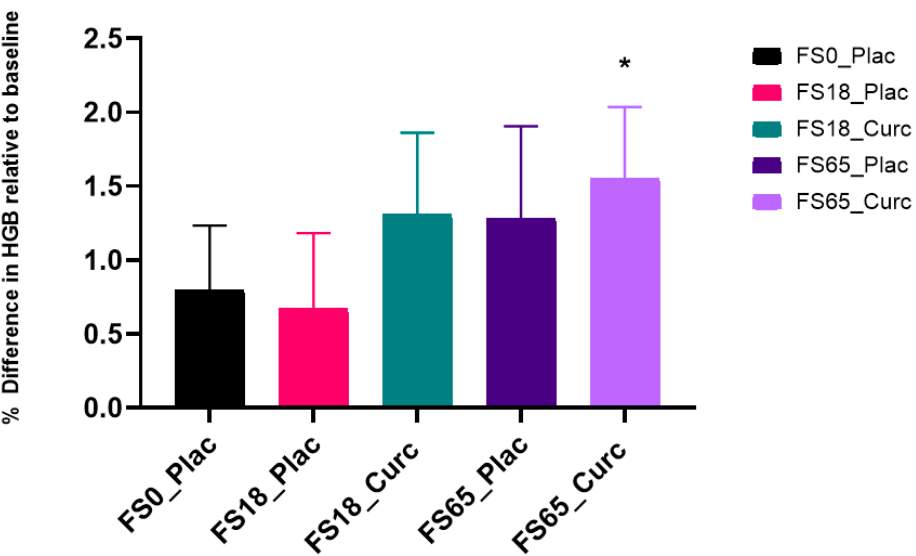
Figure 6. Haemoglobin (HGB) levels are expressed as percentage difference compared to baseline levels (SEM). * repre- sents significant difference over time (* p < 0.05).